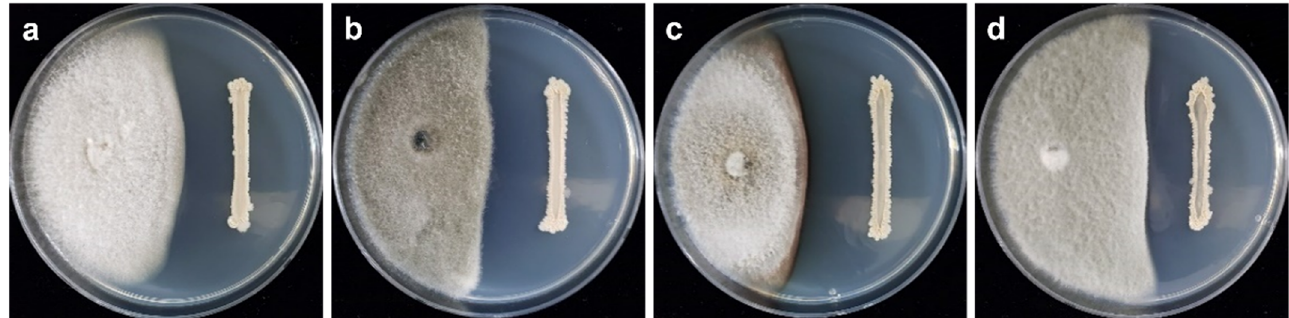
Figure 1. Inhibition of the growth of various phytopathogenic Colletotrichum species by B. veleznesis CE 100. Histograms represent the mean ± standard deviation of three replications. Different letters represent significant differences (LSD test, p < 0.05).